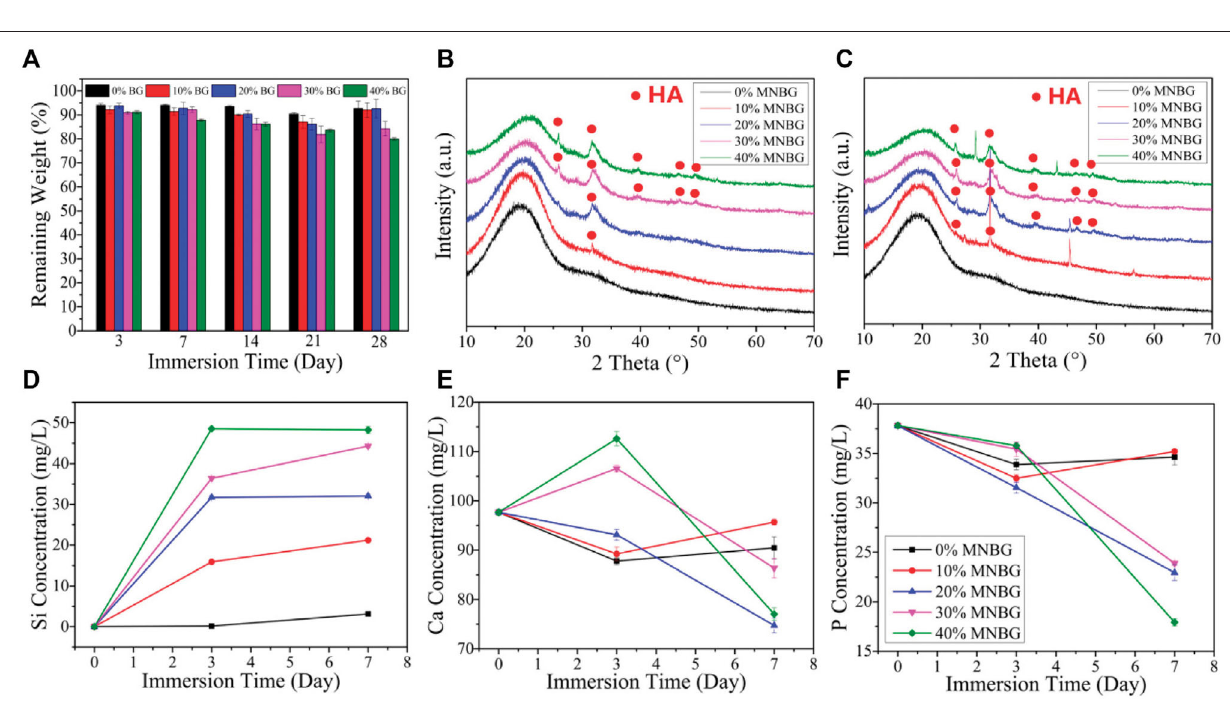
FIGURE 4 | Biodegradation and apatite-forming ability of composite scaffolds in SBF. (A) Mass loss behaviors of scaffolds in SBF during 28 days immersing. (B,C) XRD patterns of scaffolds after soaking in SBF for 3 days (B) and 7 days (C) . (D–F) Ions release curves of scaffolds for (D) Si; (E) Ca; (F) P after soaking in SBF for 3 and 7